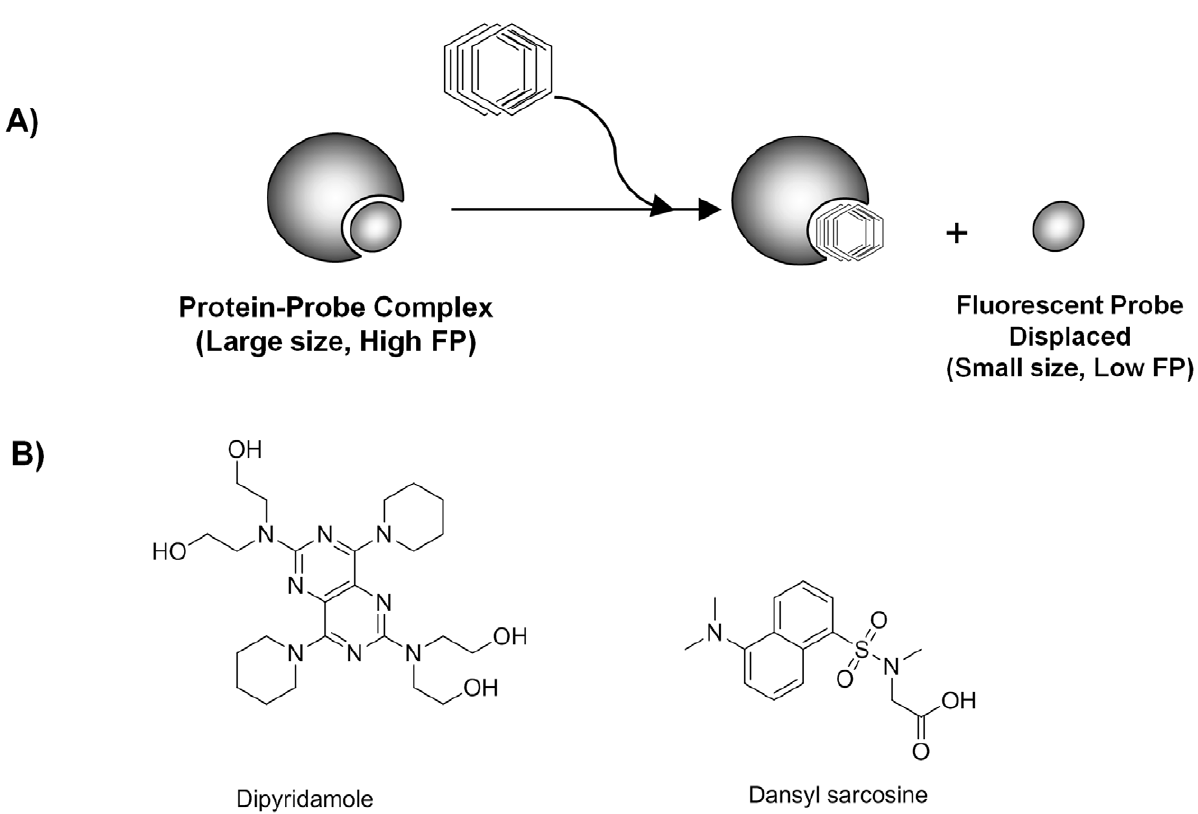
Figure 1. Fluorescence polarization assay. A) assay principle; B) structures of the fluorescent AGP and HSA probes Dipyridamole and Dansyl sarcosine,